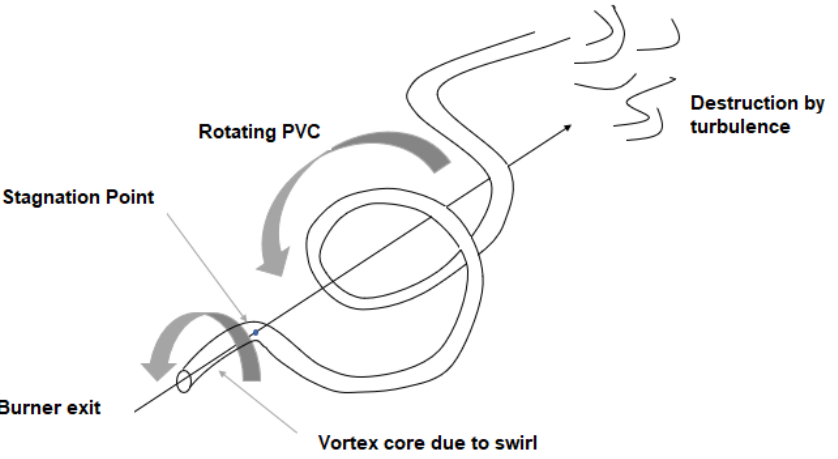
Figure 3. Vortex structure of PVC